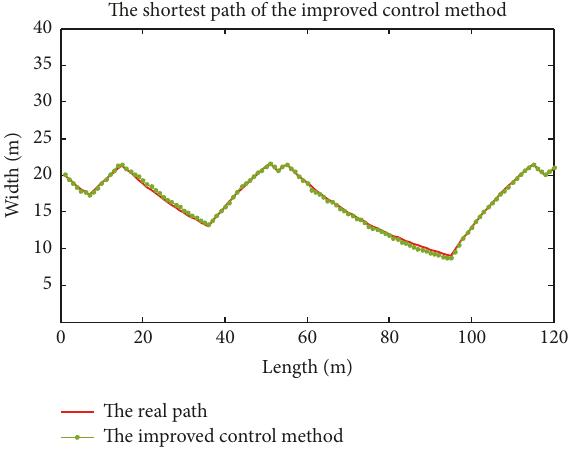
Figure 4: The shortest path of the improved control method.